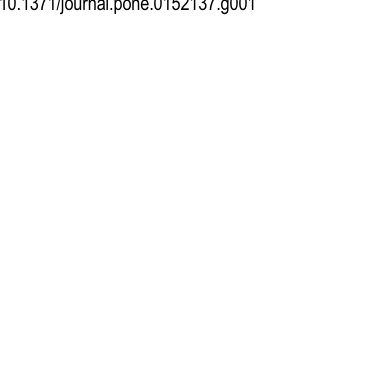
Fig 1. Participant flow